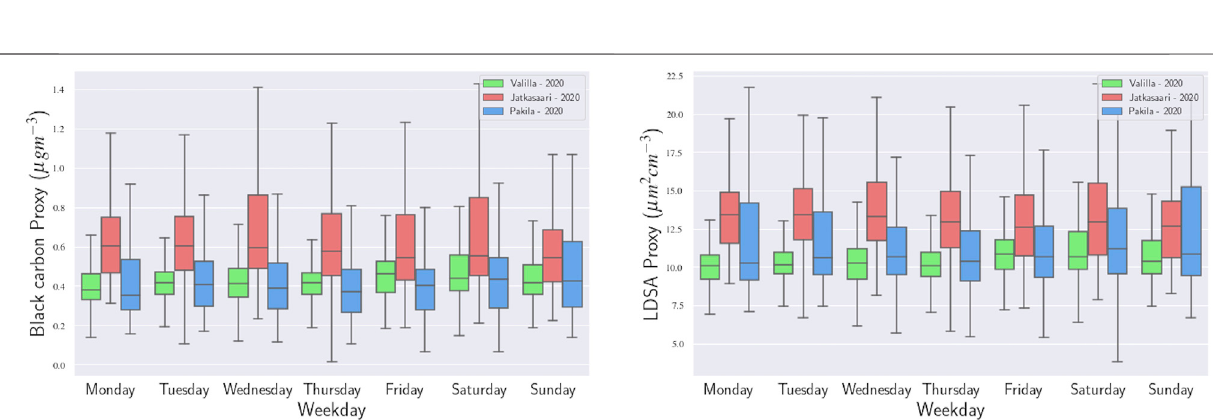
Frontiers in Environmental Science |